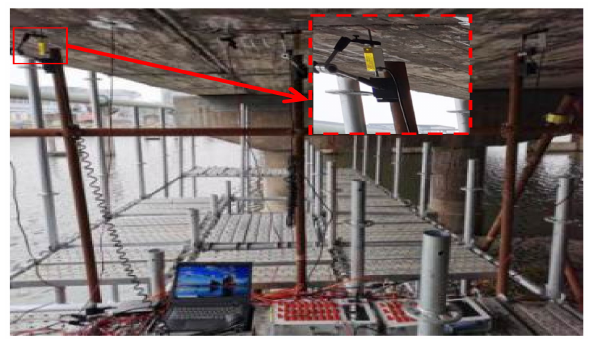
Figure 7. Static